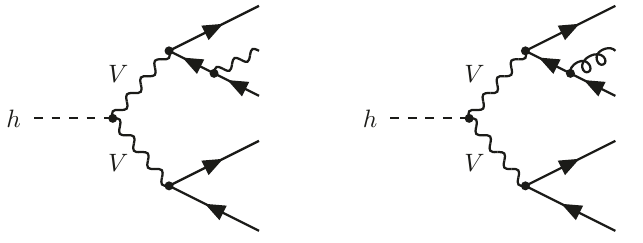
Figure 7 . Exemplary diagrams for the real-emission processes h ! 4 f + (cid:13) and h ! 4 f +g included in the NLO